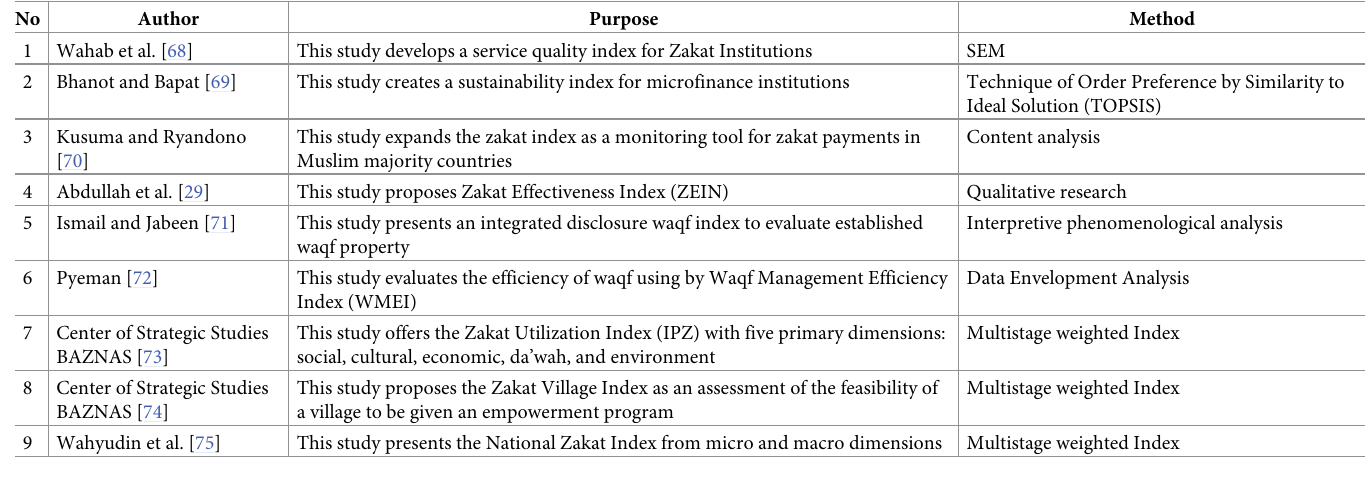
Table 2. Prior Studies of Islamic Social Finance